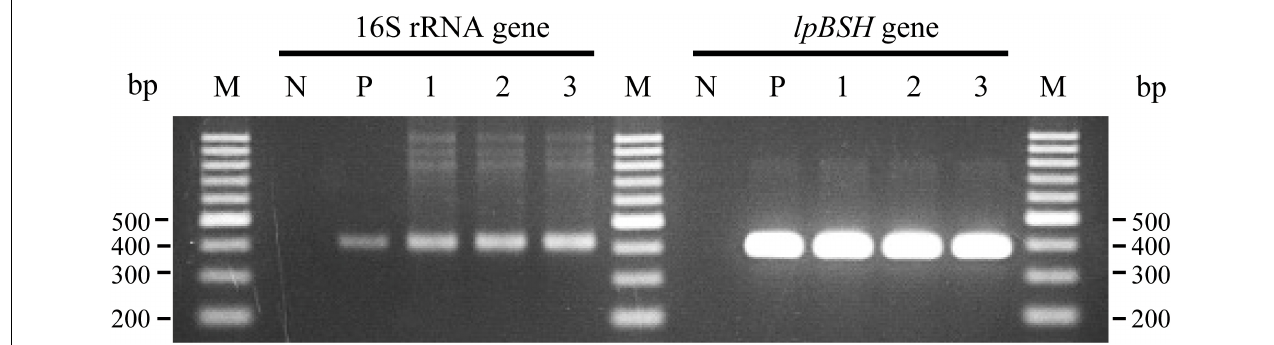
FIGURE 5 | Reverse transcription-polymerase chain reaction analyses of lpBSH gene in L. paragasseri JCM 5343 T . The synthesized cDNA samples from total RNA of non-supplemented (lane 1), TDCA-supplemented (lane 2), and cephalosporin C-supplemented (lane 3) strains of JCM 5343 T cells were used as the template for PCR analysis, respectively. Sterilized water (lane N) and genomic DNA of strain JCM 5343 T (lane P) were used as negative and positive control templates, respectively. The 16S rRNA gene was used as internal standard control. Lane M, molecular size markers (100 bp DNA ladder, Promega, Madison, WI, United States).